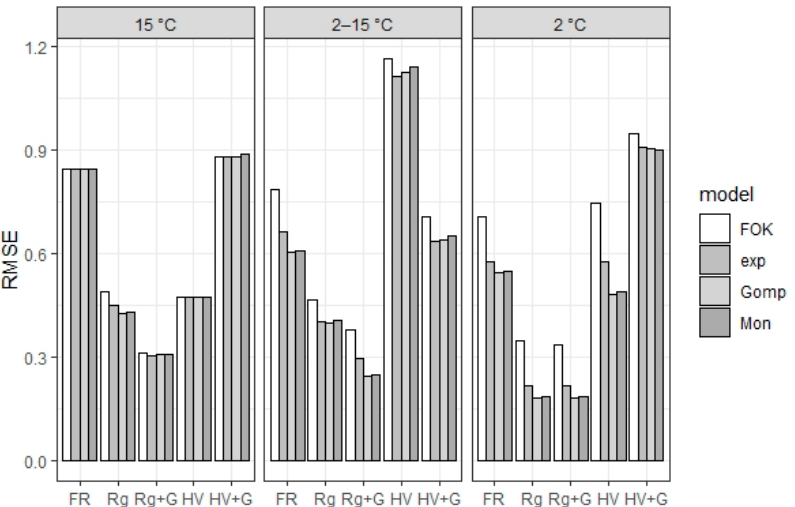
Figure 6. Root-mean-square error (RMSE) of different functions fitted to experimental net N mineralization of catch crop residue at different incubation temperatures data by the nonlinear least-squares